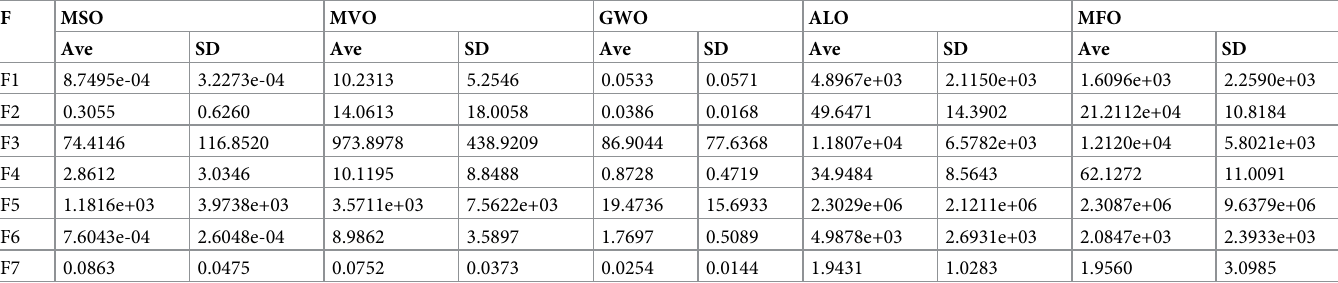
Table 3. Results of unimodal benchmark functions.